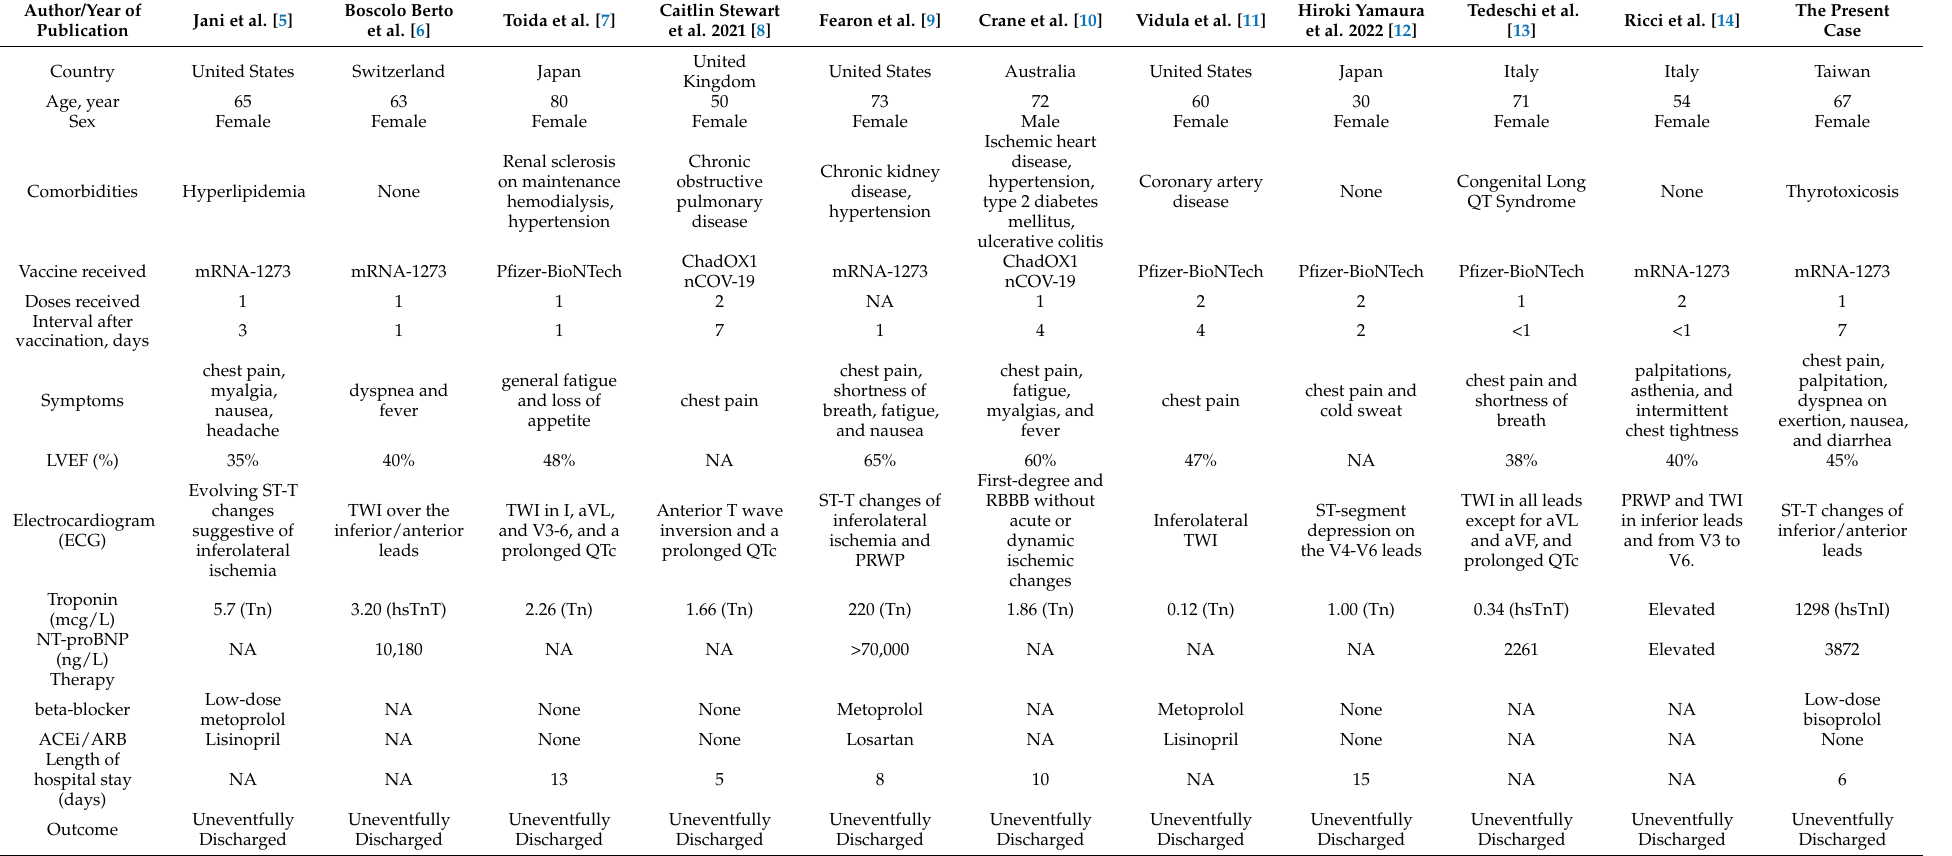
Table 1. Takotsubo Syndrome Occurring after COVID-19